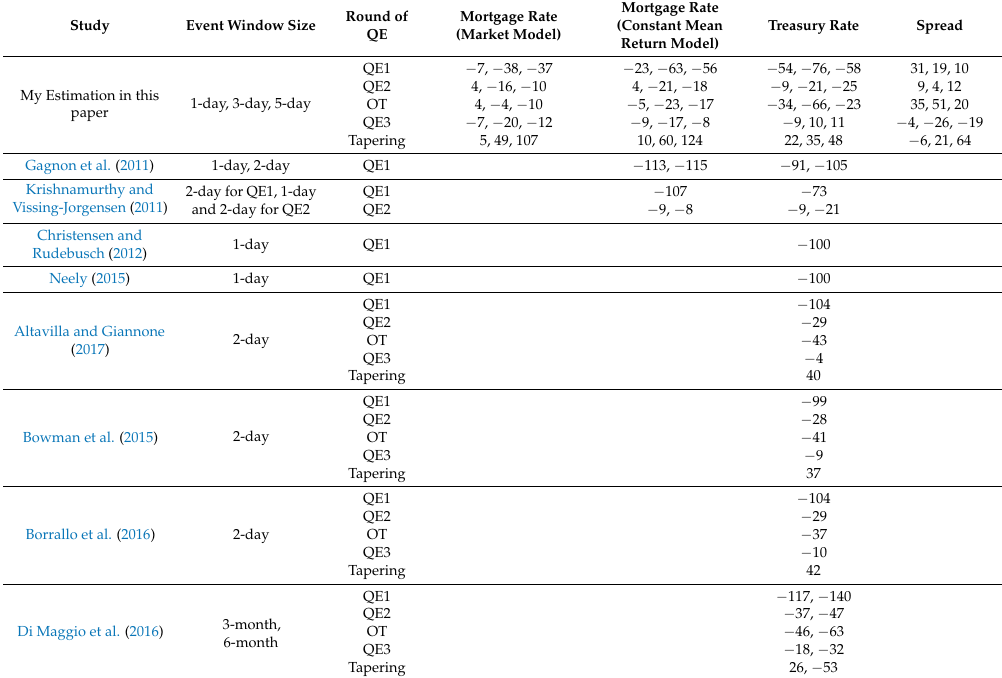
Table 5. Cumulative effects of QE announcements on the mortgage rate and Treasury rate. Row 1 reports the cumulative abnormal returns of the 30-year mortgage rate, the 30-year Treasury rate and the spread between them across all announcements in each round of QE with 1-day, 3-day and 5-day event windows from my estimation. As a comparison, the cumulative effects on mortgage rates and MBS yields found in other literature are reported. The cumulative changes of the 30-year MBS yield and the 30-year Treasury rate are found in Krishnamurthy and Vissing-Jorgensen (2011) and Di Maggio et al. (2016), all other studies report cumulative changes of the 10-year MBS yield and the 10-year Treasury rate. For comparison purposes, we only focus on “easing” announcements, four events of